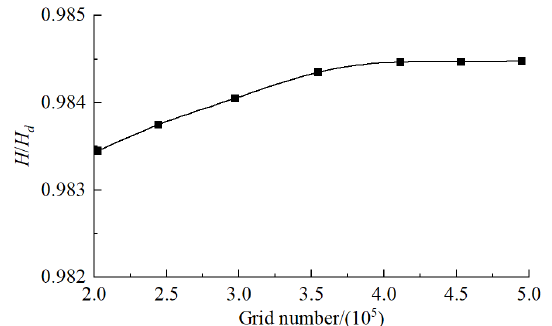
Figure 2. Grid independency test.